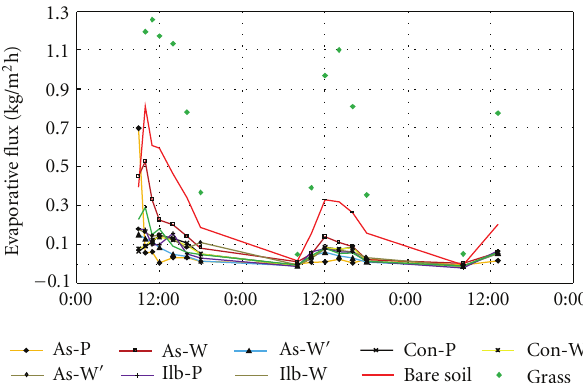
Figure 10: Relationship graph for estimation of heat capacity in the case of As-N.